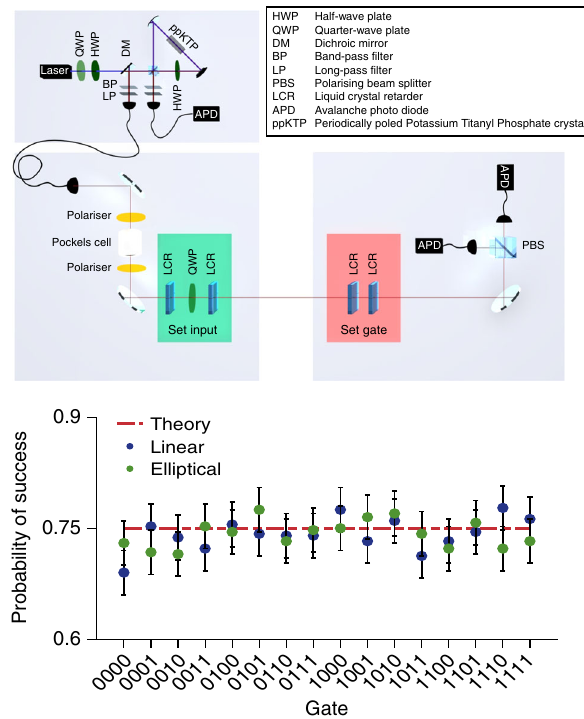
Fig. 3 Experimental one-time program implementation. a Our setup: marked in green are the liquid crystal retarders (LCRs) and quarter-wave plate (QWP) used to manipulate the polarisation state of single photons which corresponds to setting the individual gates of the encoded program. The LCRs marked in red are used by Bob to set the measurement basis according to the gate inputs. On Alice ’ s side an active switch is implemented based on a Pockels cell placed between two crossed polarisers acting as a fast switching half-wave plate. Alice produces single photons with a source in a Sagnac con fi guration 28 – 30 . In ( b ) we show the average success probability per gate for all G 2 gates. Blue dots represent the results for the linear scheme, green dots the results for the elliptical scheme and the theoretically predicted value is shown by the red line. The gates are labelled by the last column of their truth table, e.g. (00 → 0, 01 → 1, 10 → 0, 11 → 0) corresponds to 0100. Error bars show an interval of ±1 standard deviation derived from binomial statistics and are therefore a